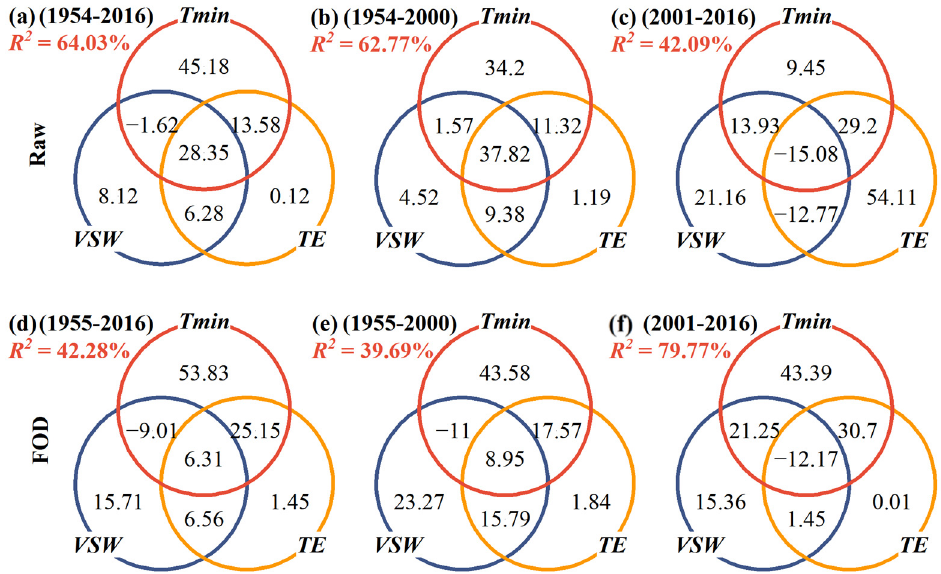
Figure 6. The proportion of contribution (%, the numbers inside the Venn diagram) of Tmin , VSW and TE in explaining the variance of TRW at different time periods by using commonality analysis.